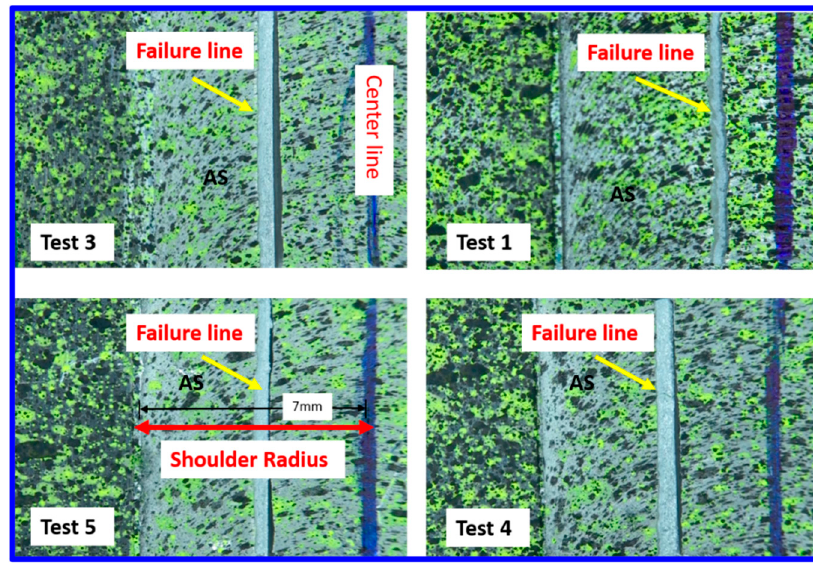
Figure 11. Fracture line location in four FSW tests after the simple tensile test.